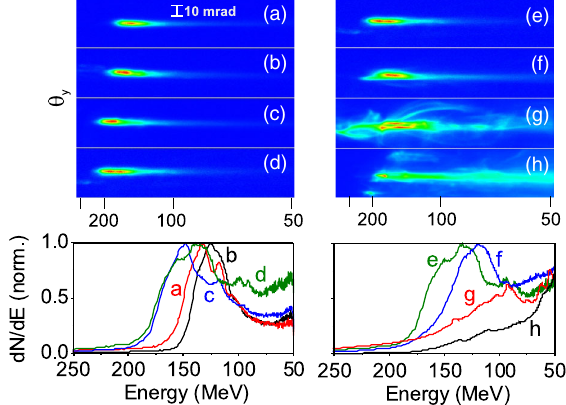
FIG. 3. Electron energy spectra obtained for laser power of 26 TW; the color scale is normalized for each shot. The left column [panels (a)–(d) and the plot at the bottom] shows LANEX images and corresponding lineouts for the lowest plasma density ( 1 : 2 (cid:2) 10 19 cm (cid:3) 3 ), yielding stable, QME elec- tron beams. The energy corresponding to the spectral peak fluctuates between 130 and 160 MeV. The integrated charge in this energy interval is 18 (cid:4) 2 : 3 pC and the beam divergence is 4 mrad. The right column [panels (e)–(h) and the plot at the bottom] shows that the electron spectra evolve from QME to quasithermal distributions as the plasma density increases: (e) 1.2, (f) 1.5, (g) 1.8, and (h) 2 : 4 (cid:2) 10 19 cm (cid:3) 3 . Panels (d) and (e) represent the same laser